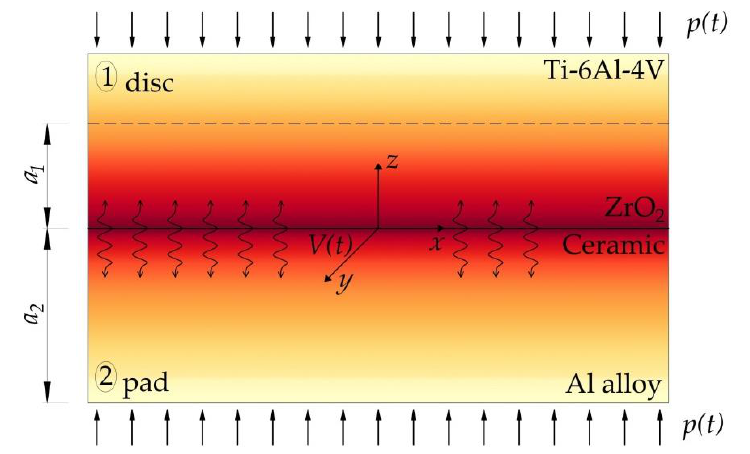
cess of frictional heating in the disc – pad system.